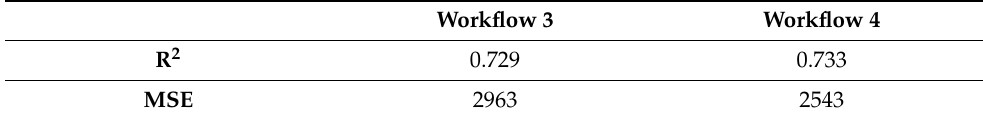
Table 4. Validation of workflows 3 and 4.